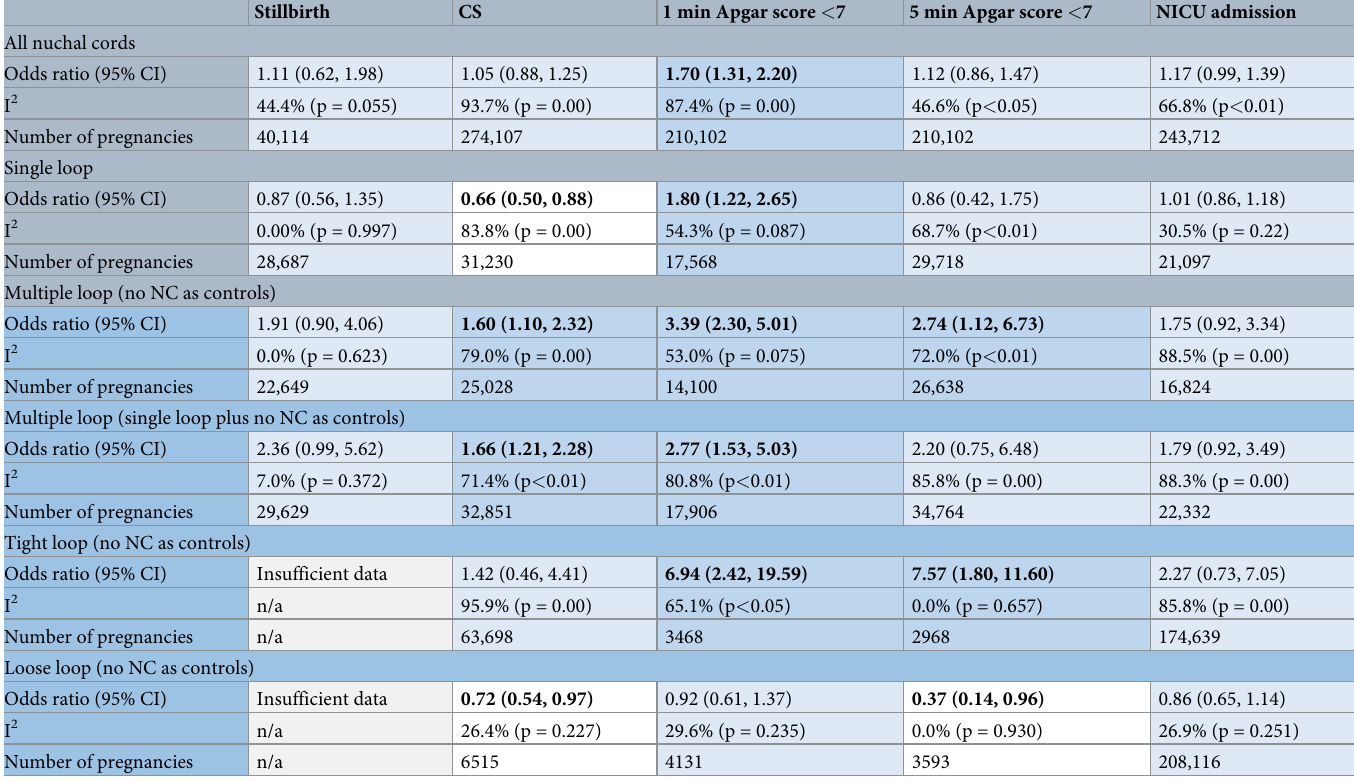
Table 2. Analyses of the relationship between nuchal cord and adverse outcomes.